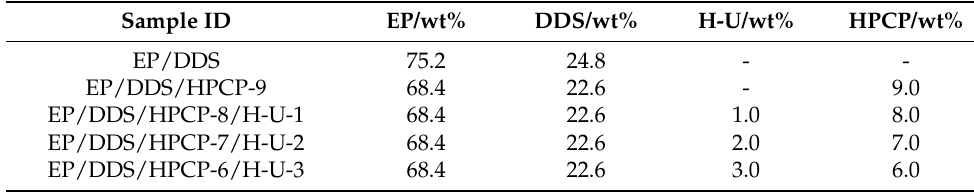
Table 1. Formulas of EP and its